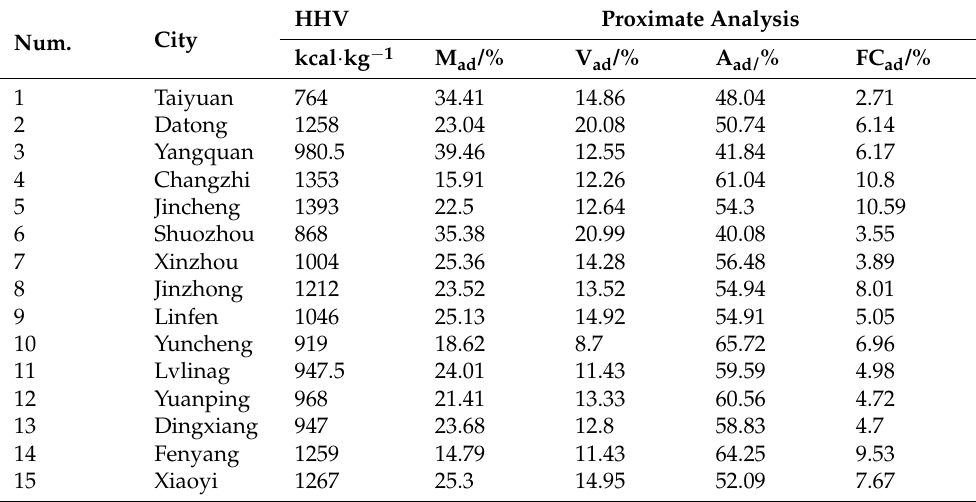
Table 1. The HHVs and proximate analysis of MSWs of 15 cities in Shanxi Province.